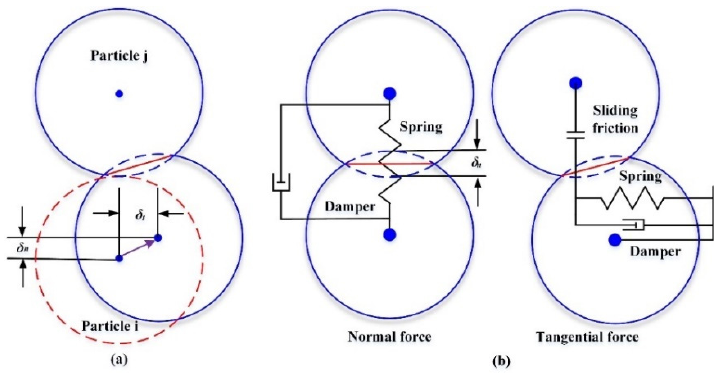
Figure 2. ( a ) Normal displacement δ n and tangential displacement δ t of particle collision; ( b ) consti- tutive model of the interaction between two particles. (adapted from [22], with permission from THE ROYAL SOCIETY, 2019.)